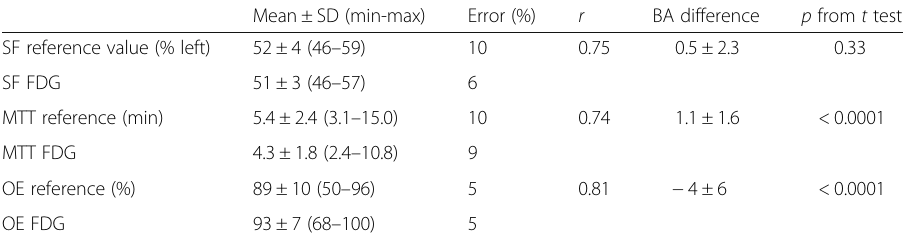
Table 2 Results of total kidney values: mean values ± standard deviation (SD) as well as total errors, correlation coefficient ( r ), differences from Bland-Altman analysis (BA), and the p values from the Student ’ s t test. Displayed parameters are outflow efficiency (OE), mean transit time (MTT), and split function (SF); the latter for the integral 1 to 2 min in case of FDG values, and 1 to 3 min in the case of reference